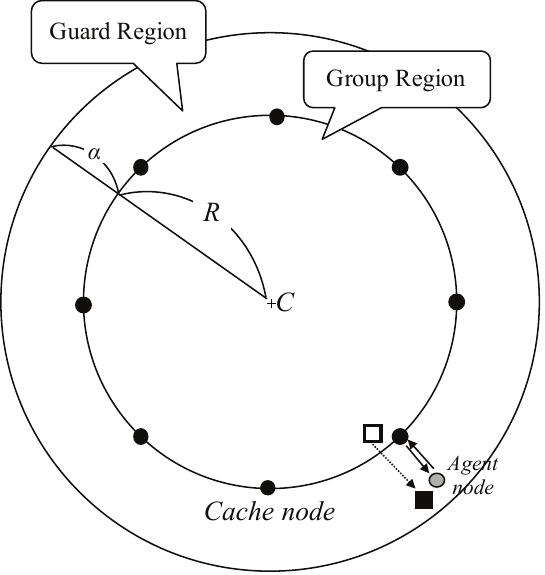
Figure 5. An example of a guard region and cache